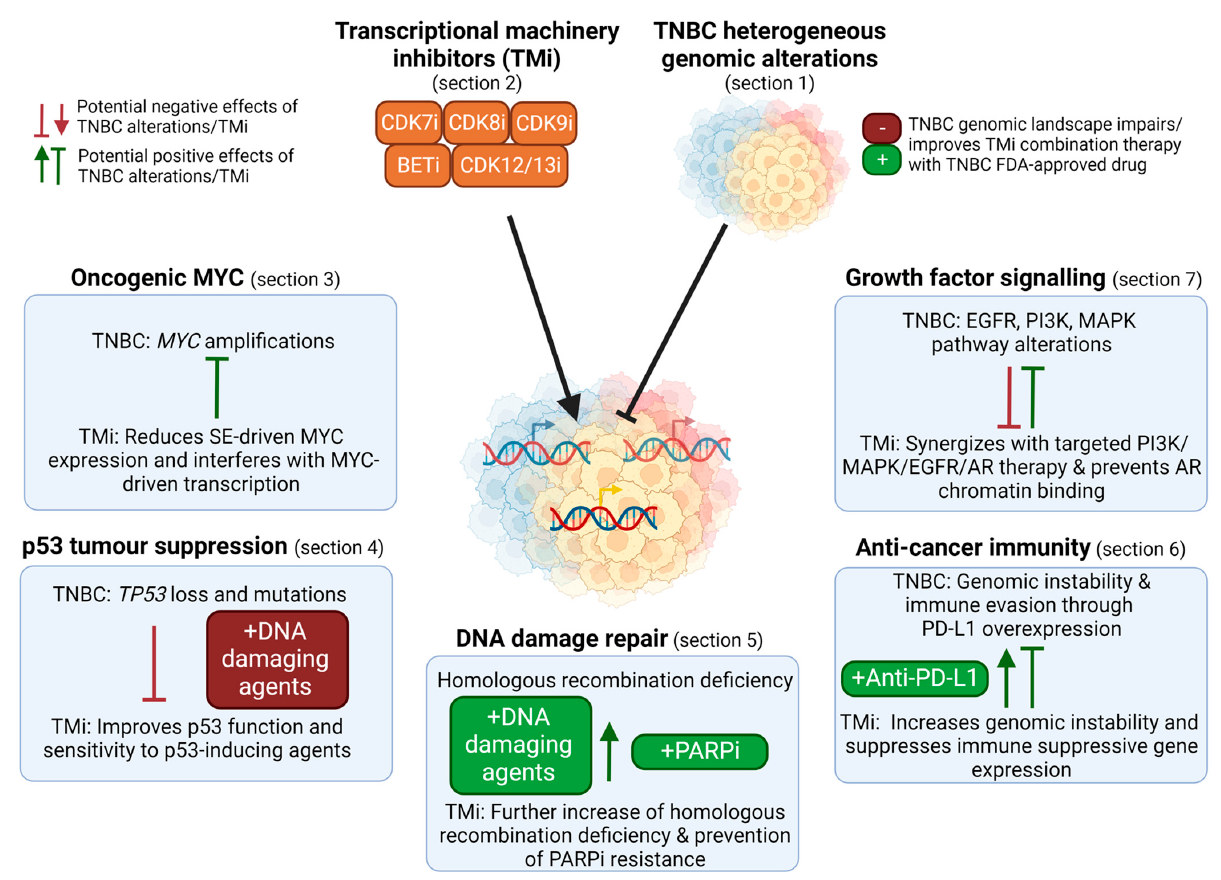
Figure 2. Overview of the use of TM inhibitors (TMi’s) to tackle the genomic landscape in TNBC. TMi’s can suppress super-enhancer (SE) driven MYC expression and interfere with MYC-driven transcription (Section 3). As TMi’s can improve p53 function and thereby synergize with DNA damaging agents, genomic loss of TP53 in TNBC can reduce the efficacy of these combination therapies (Section 4). TNBC is characterized by frequent homologous recombination deficiencies and TMi’s further induce genomic instability, thereby sensitizing cells to DNA damaging agents and PARP inhibitors. Despite their genomic instability that could evoke immune responses, TNBCs suppress this, for example through PD-L1 overexpression (Section 6). TMi’s further induce genomic instability and prevent immune suppressive gene expression, improving anti-cancer immunity and anti-PD-L1 therapy. Furthermore, TMi’s can improve therapies directed against the elevated levels of growth factor or AR signaling pathways in TNBC, such as PI3K and MEK inhibitors (Section 7). This figure was created with BioRender.com (accessed on 8 August